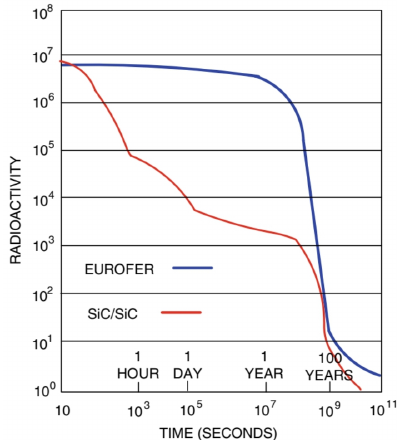
Figure 12. EUROFER and SiC/SiC radioactive decay in logarithmic scale. The vertical axis is in units of Bq/kg. Reprinted from Ref.